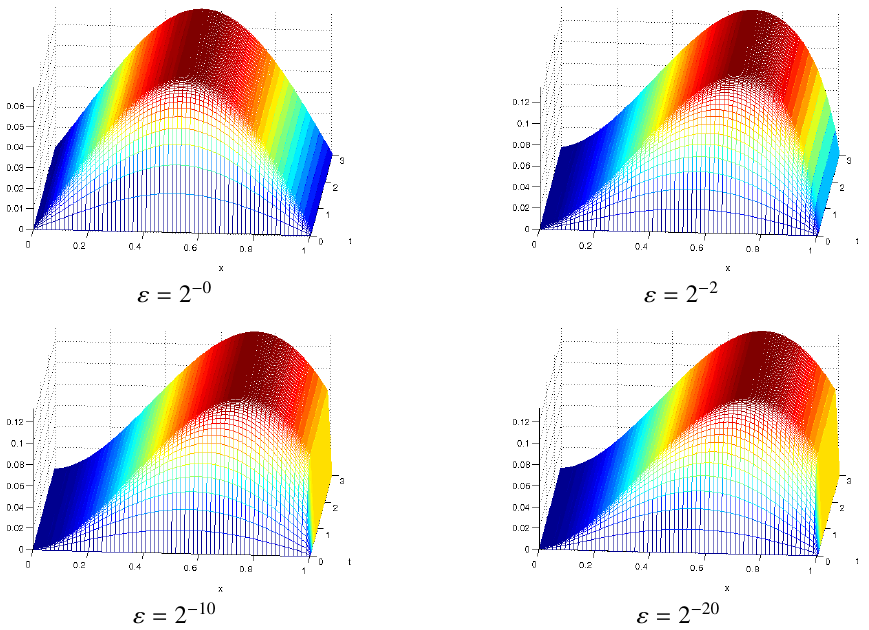
Figure 2. 3D view of numerical solution of Example 4.2 with boundary layer formation as ε →